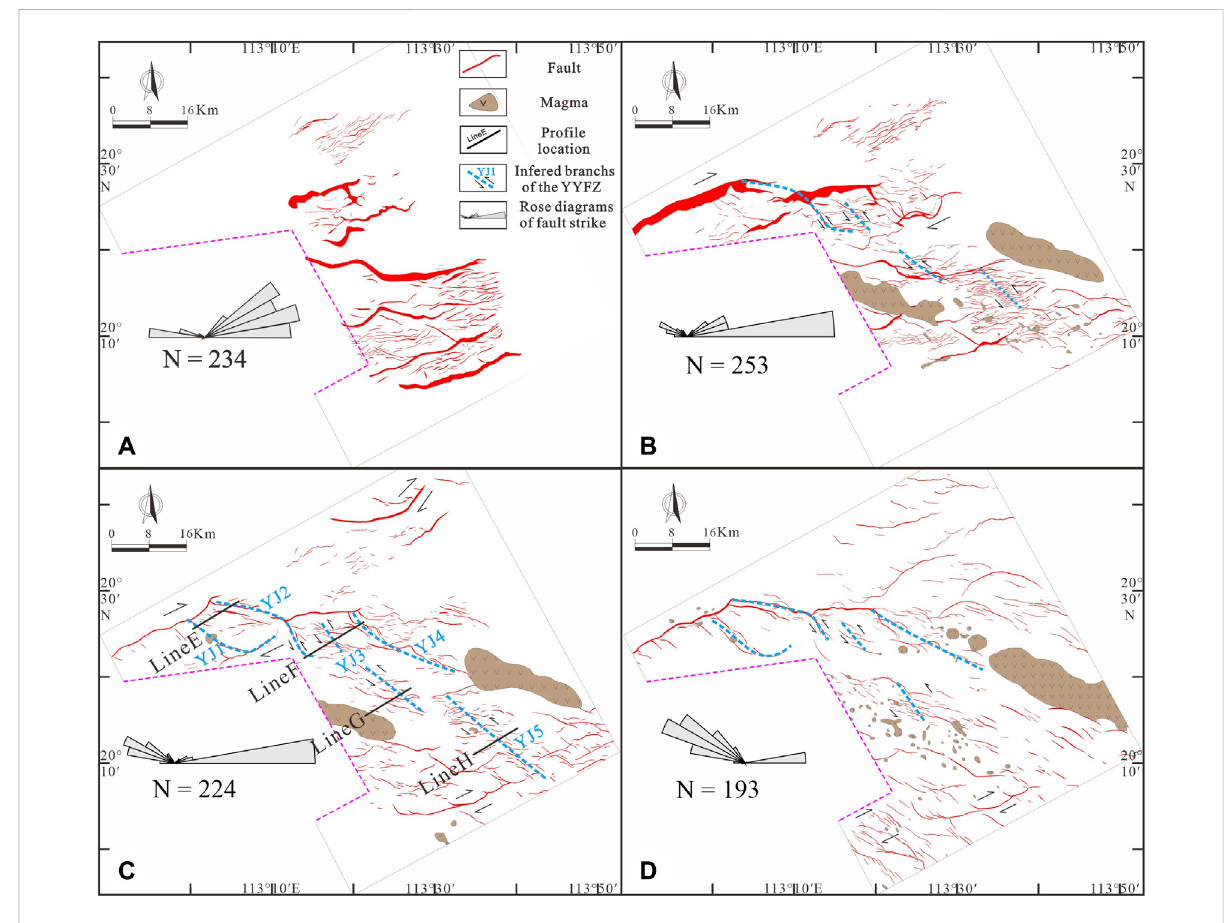
FIGURE 6 Fault patterns in different seismic re fl ectors of the Yangjiang Sag. (A) -T 82 ; (B) -T 80 ; (C) -T 70 ; (D) -T 40